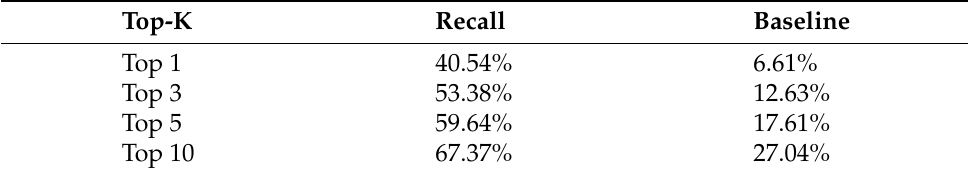
Table 8. The results of top-k prediction.